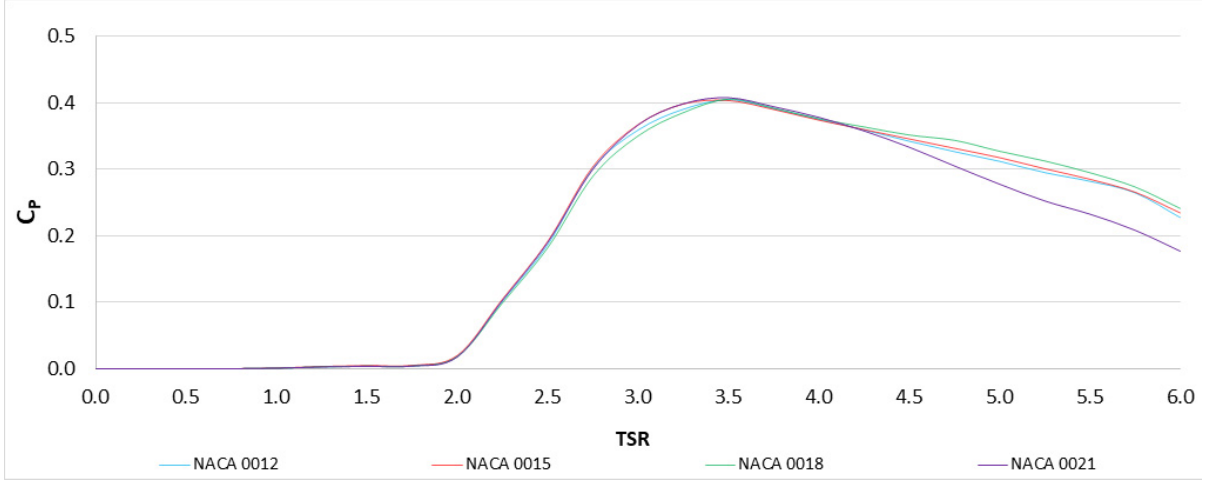
Figure 4. Coefficient of power vs. TSR plot for different airfoil thickness. Figure 5. Coefficient of power vs. TSR plot for different airfoil